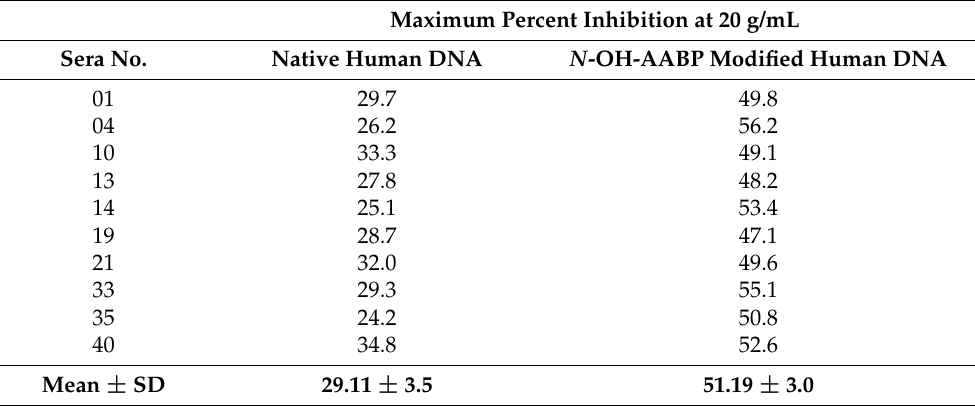
Table 2. Competitive inhibition data of IgG from non-smoker group of bladder cancer